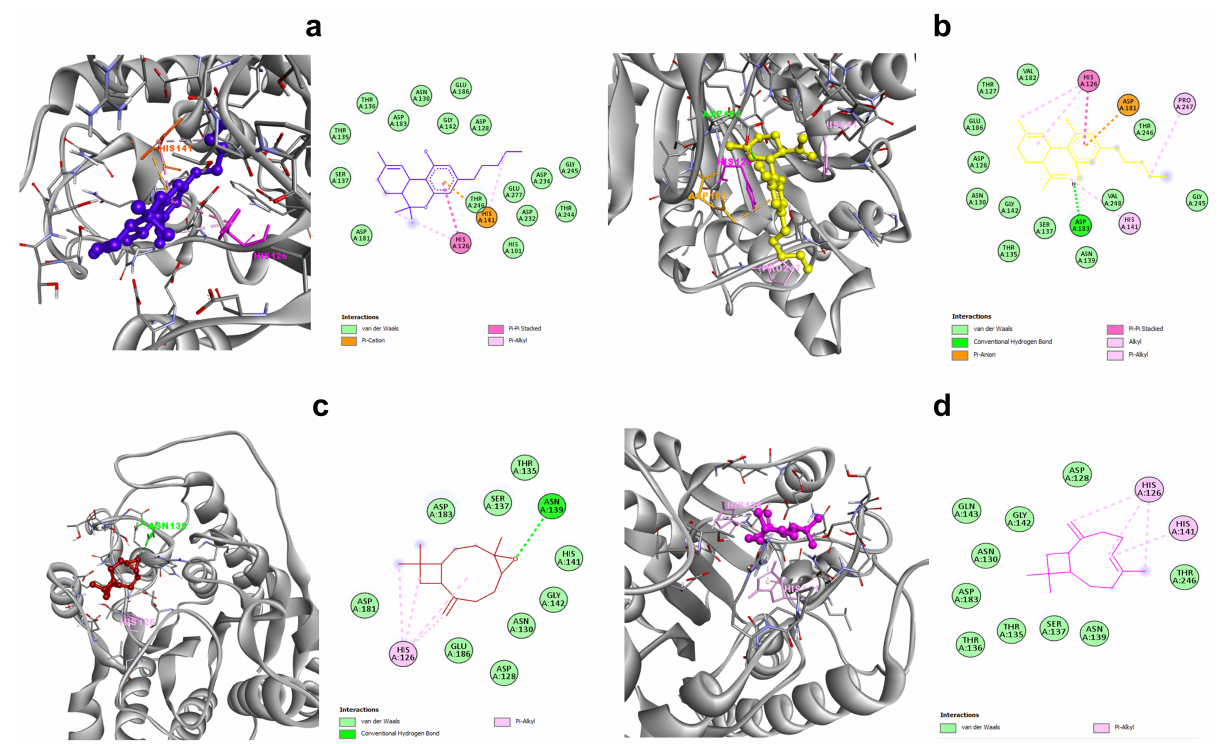
Figure 2. Visualization of interactions between various C. sativa compounds and human arginase. Interaction of delta-9-THC ( a ), CBD ( b ), caryophyllene oxide ( c ), and beta-caryophyllene ( d ) with the h-Arg protein and its linked amino acid